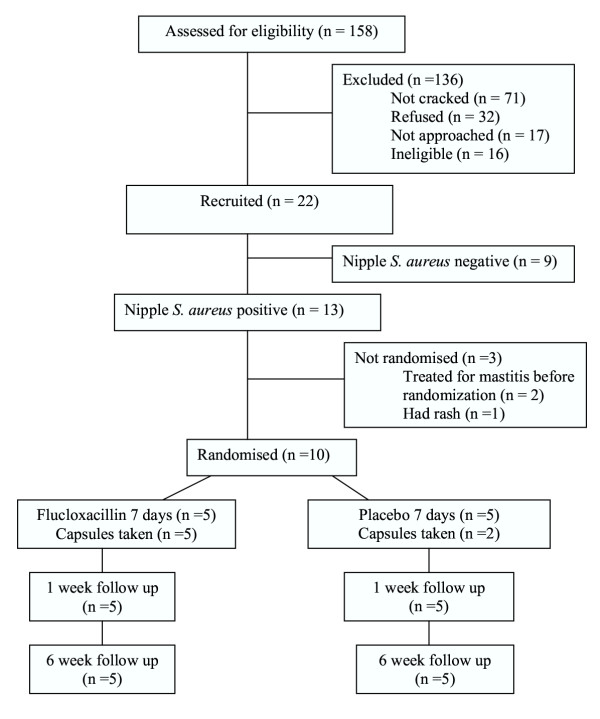
ROBIn Trial Profile